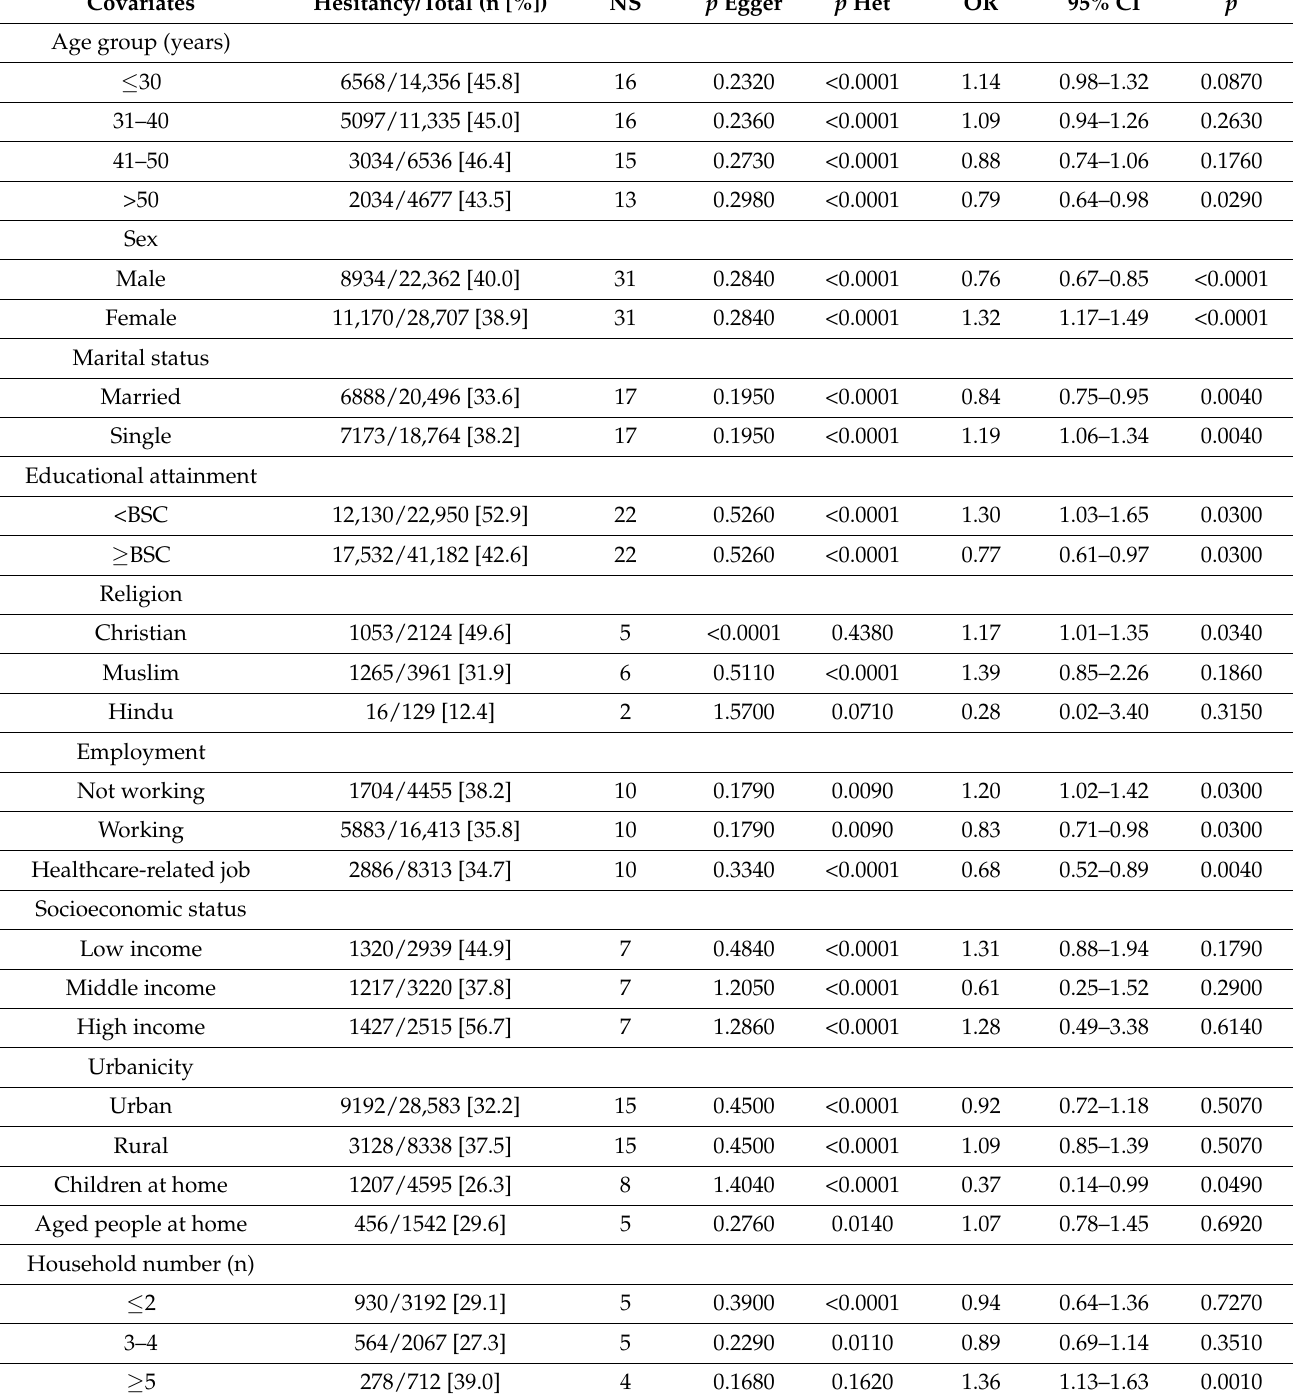
Table 2. The potential factors associated with the hesitancy to COVID-19